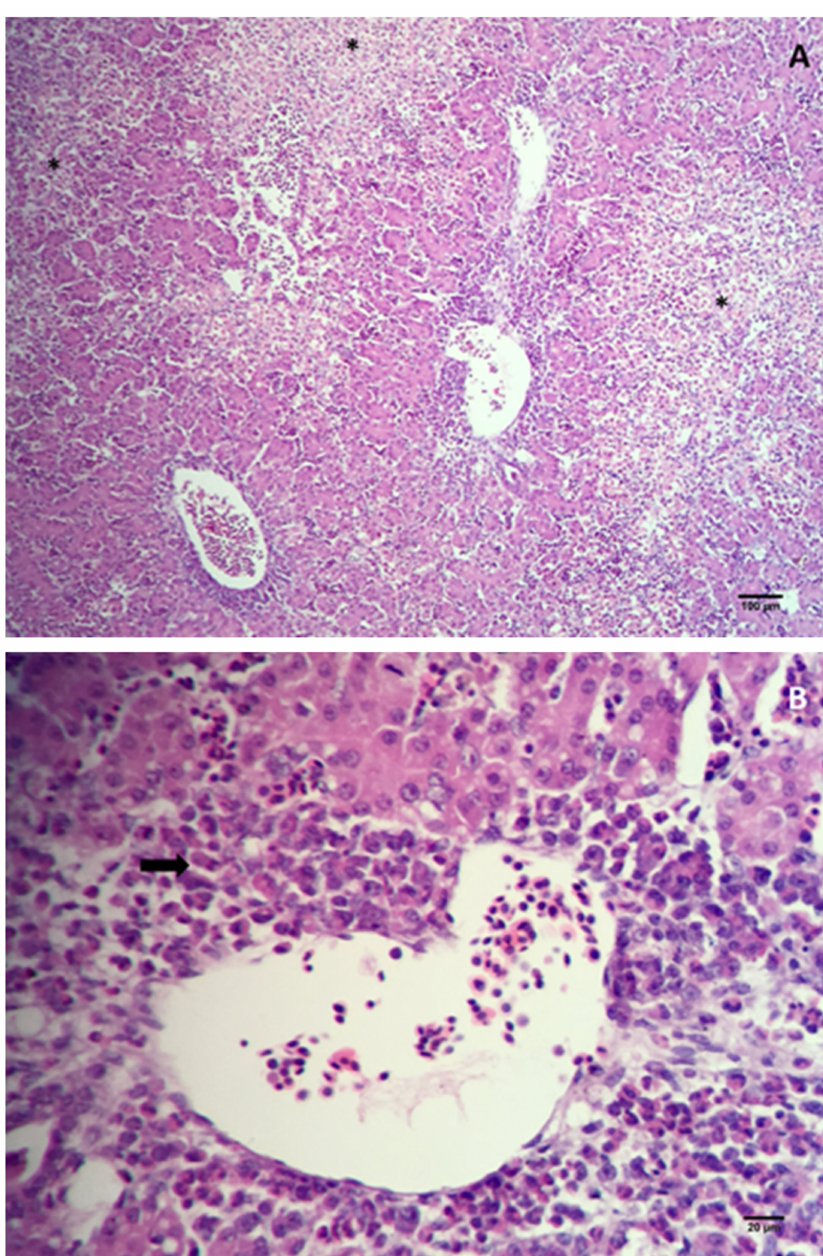
Figure 2. Photomicrography of liver sections from chicks with a one-day-old WCS. Liver parenchyma showed necroses—asterisks ( A ) and increases in the infiltrate of granulocytes—arrow ( B ) indicating necrosis hepatitis. All slides were stained with hematoxylin–eosin